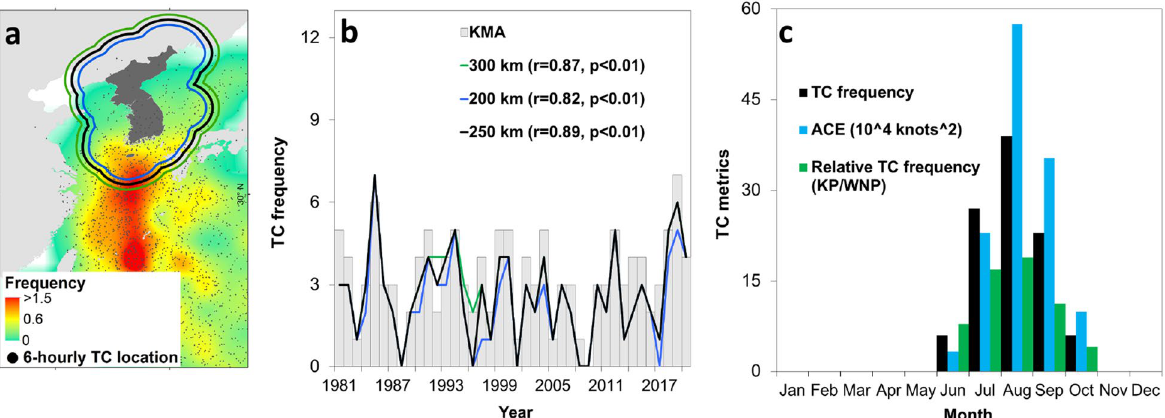
Figure 1. Climatology of tropical cyclones (TCs) passing through the Korean Peninsula (KP). ( a ) Climatological composite map of KP-influence TC frequency gridded into 2° × 2° horizontal resolution from 1981 to 2020. The green, blue, and black contour lines correspond to the 300, 200, and 250 km buffer zones away from the KP region (dark gray filled area), respectively. ( b ) Timeseries of frequency of KP-influence TCs based on the Korea Meteorological Agency (KMA, bar) and TC passage frequency in the 300 (green), 200 (blue), and 250 (black) km buffer zones, respectively. ( c ) Monthly mean of KP-influence TC frequency (black), Accumulated Cyclone Energy (ACE, blue), and relative KP-influence TC frequency with respect to the Western North Pacific (WNP) TC frequency (green), respectively. In ( a ) the map is plotted using ArcGIS 10.1 (https:// www. esri.